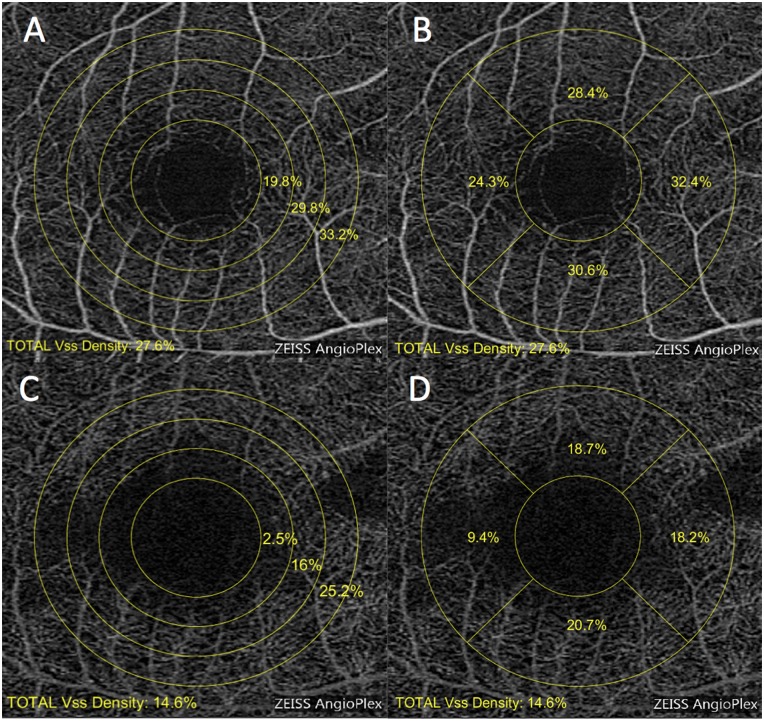
Macular vascular density at the different levels of 3 x 3-mm retinal vascular plexus.(A) Superficial retinal vascular plexus in circular segmentation. (B) Superficial retinal vascular plexus in quadrant segmentation. (C) Deep retinal vascular plexus in circular segmentation. (D) Deep retinal vascular plexus in quadrant segmentation. For the circular segmentation, vascular density was calculated in three circular regions of different radius after excluding the adjacent inner circle area. Each region corresponding to C1, C2, and C3 had a 1.5-mm, 2-mm, and 2.5-mm radius from the center. The central area of 1-mm radius was excluded, most of which included the FAZ area. Similarly, quadrant segmentation was performed in four sectors, namely, temporal (T), superior (S), nasal (N), and inferior (I) in the region of 1-mm to 2.5-mm radius.